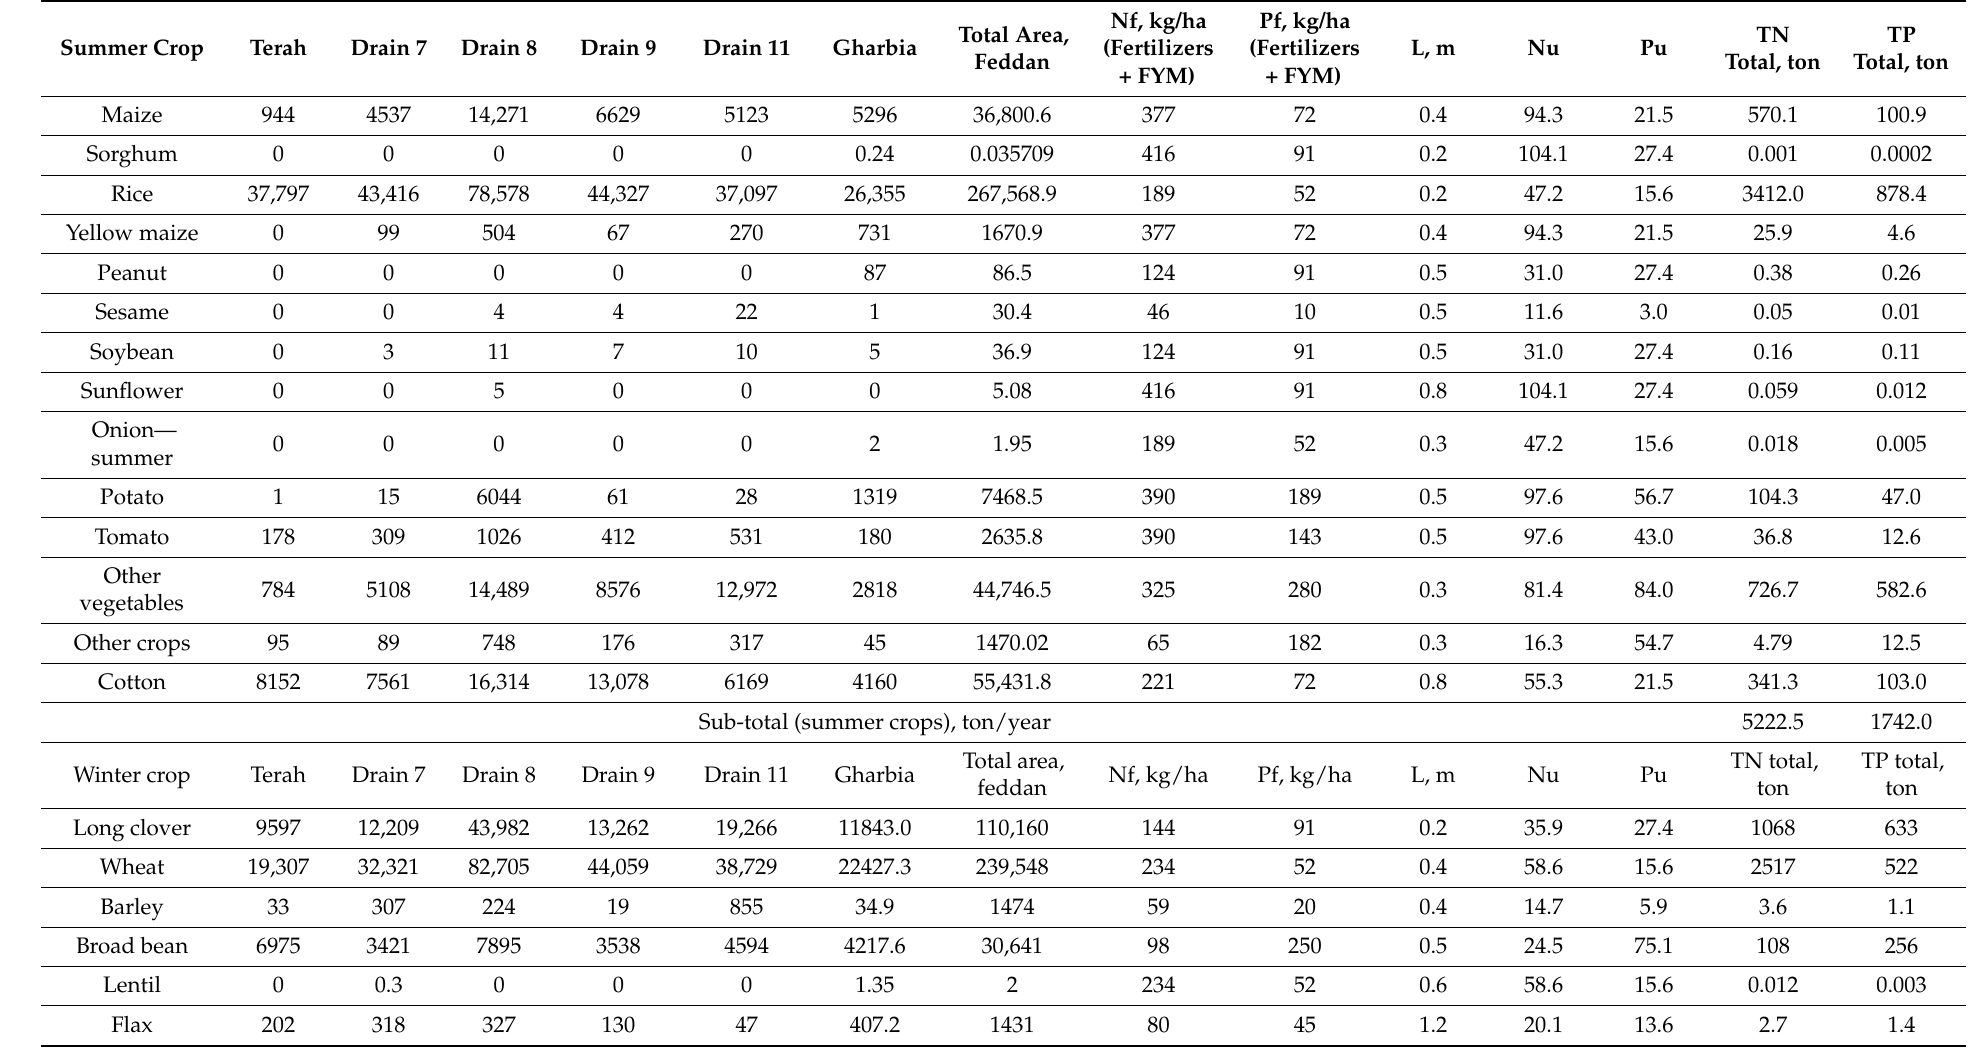
Table 4. TN and TP loads generated from agricultural areas for each